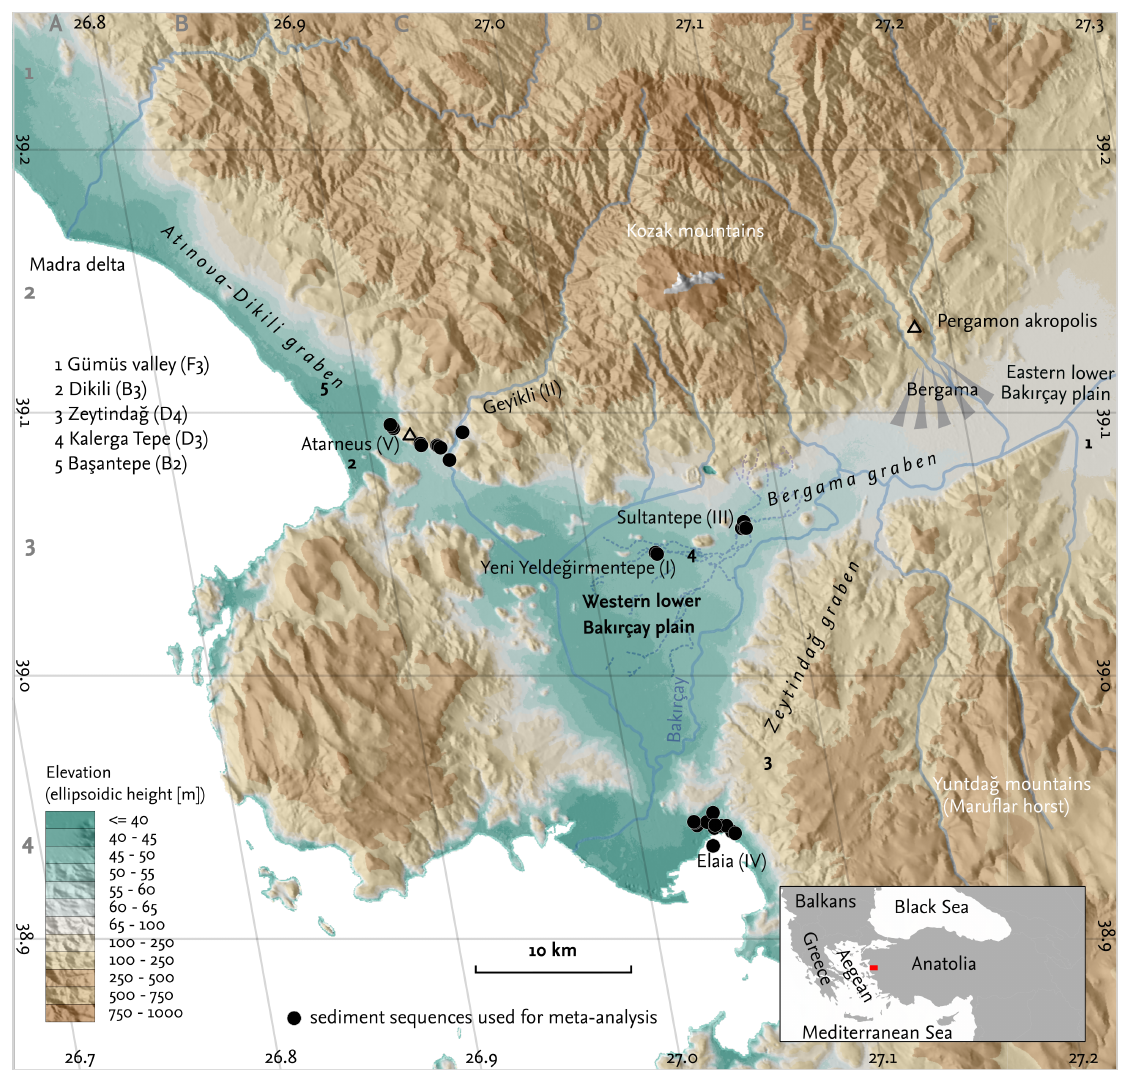
Figure 1. Overview map of the western lower Bakırçay plain. Sampling locations of the sediment sequences referred to in the current study are highlighted; main grabens are named and selected rivers/creeks and settlements are shown (some are indicated by bold numbers). For details on the sediment sequences see Table 1. Database: TanDEM-X digital elevation model [45,46], rivers partly digitized from Open Street Map-data [47]; locations of sediments according to